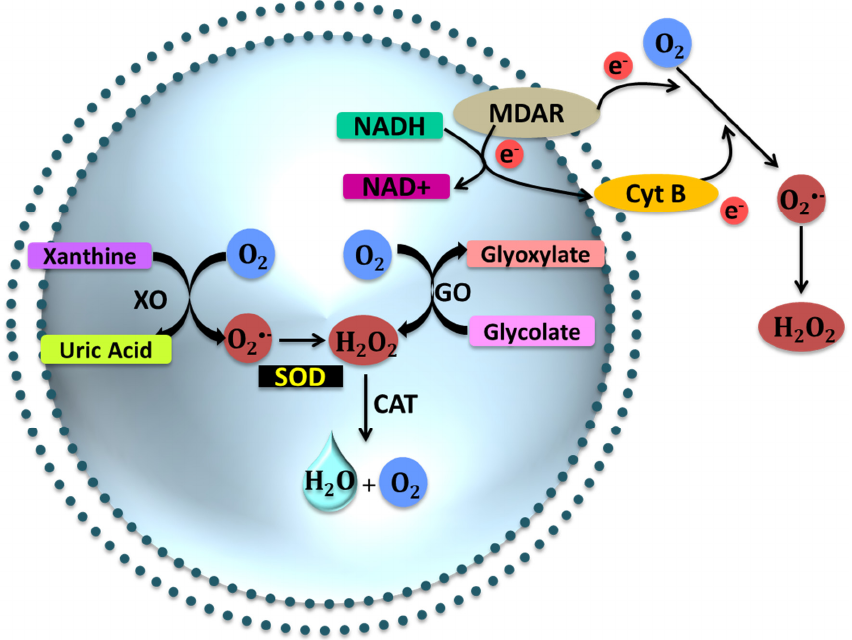
Figure 3. The process of redox in peroxisome during stress. Xanthine oxidases convert xanthine and hypoxanthine to uric acid and O 2– , while the proximal membrane produces O 2– via NADH and Cytb.